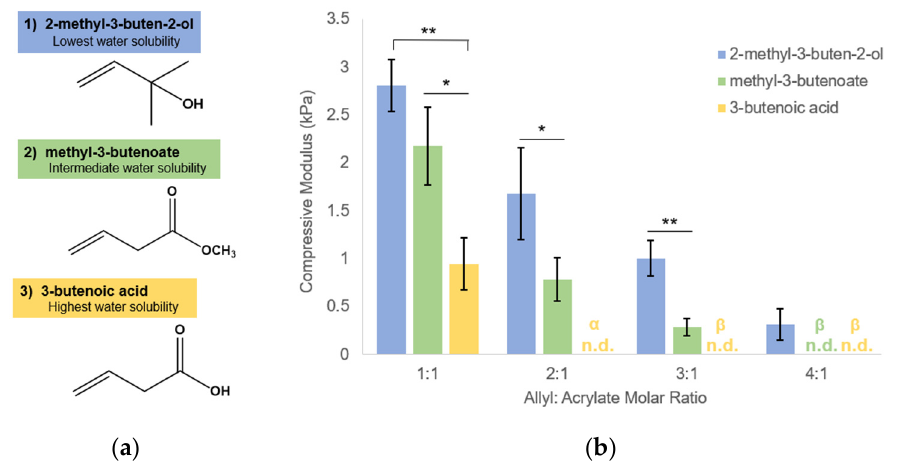
Figure 3. PEGDA modulus can be controlled by multiple allyl-containing monomers and increasing monomer polarity and monomer concentration both decrease hydrogel stiffness. ( a ) allyl-presenting monomer chemical structures; ( b ) compressive moduli of hydrogels. Compressive modulus = slope of the stress–strain curve in the linear region following the toe region. Values reported as mean ± S.D. n = 4. * p < 0.05, ** p < 0.001, indicating a statistically significant difference. statistical analysis evaluated by one-way ANOVA followed by Tukey–Kramer HSD tests. n.d. indicates no data, α : gels broke before evaluated strain region, β : gels did not form.